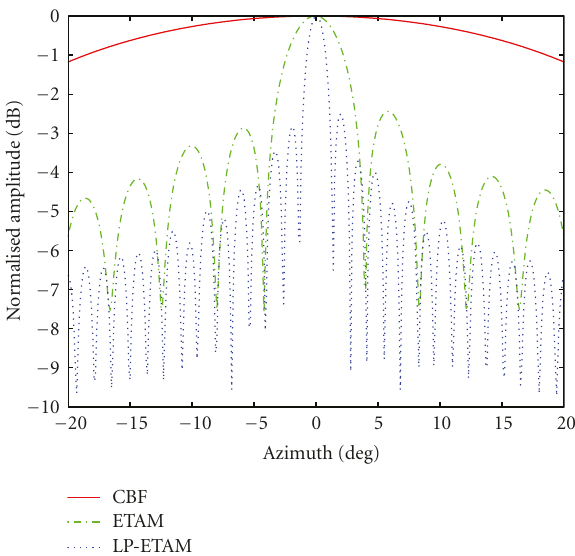
Figure 3: The comparison of spatial spectrums of the three methods for a single source.